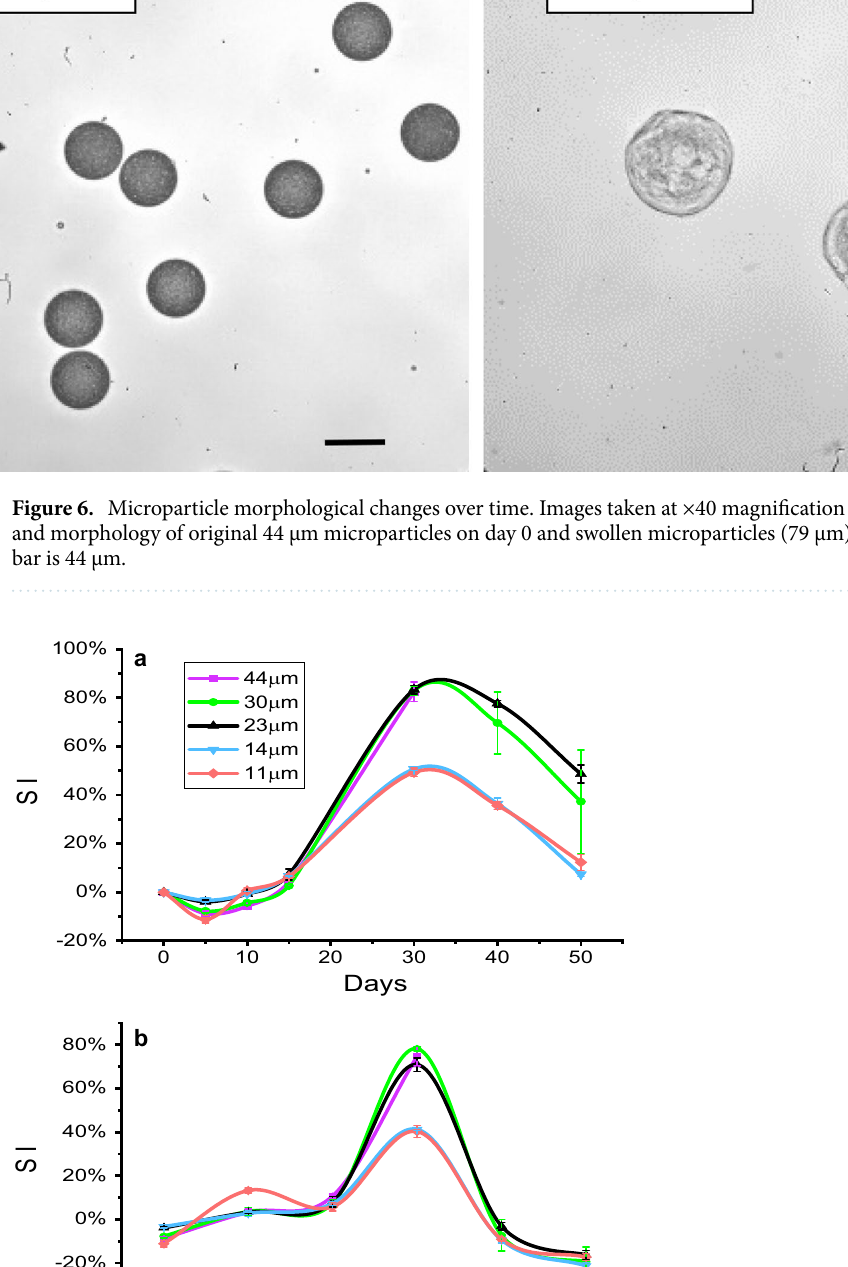
and hydroxyl groups at the ends of newly formed PLGA oligomers and monomers (Fig. 1). The Langer group reports this degradation occurs over the 15-day incubation period as seen by the precipitous drop in polymer weight-average mw. Erosion is evidenced by a change in the dry weight of the microparticle which reportedly remained constant for 15 days. The short chain acids become trapped in the polymer matrix decreasing the internal pH of the microparticle. This process starts after a couple of days of incubation and continues up to